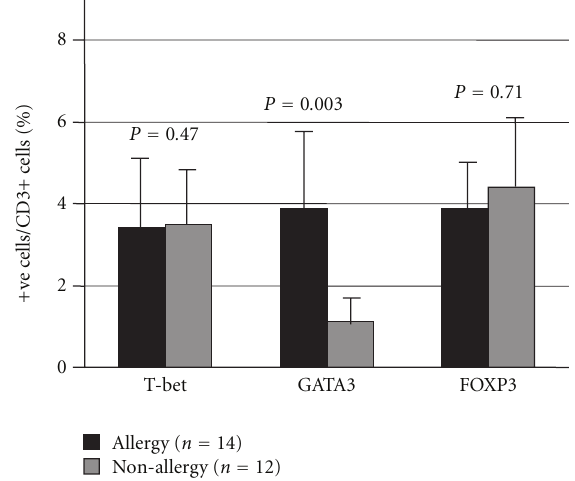
Figure 4: The percentage of T-bet-, GATA3-, or FOXP3-positive T lymphocytes in allergic ( n = 14) and nonallergic ( n = 12) nasal mucosa. Sections were stained by double immunohistochemistry (IHC) using anti-CD3 antibody and antibody against each tran- scription factor protein. The percentage of double-positive cells to IHC-positive cells was calculated. Data are the mean ±